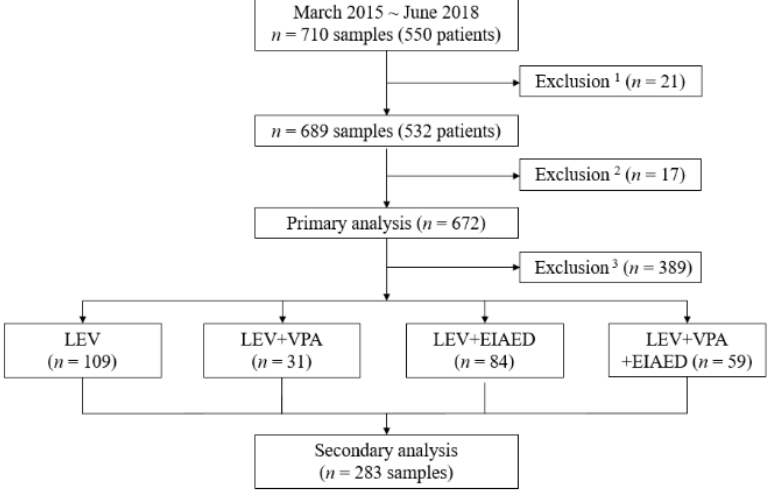
Figure 1. Study workflow. Abbreviations: LEV, levetiracetam; VPA, valproic acid; EIAED, enzyme- inducing antiepileptic drug. 1 Incomplete or unavailable medical record. 2 Below the lower limit of quantification. 3 Pediatric/elderly patient samples, intravenous injections, non-steady state samples, follow-up loss, low compliance, dose change, underlying liver and/or kidney diseases in addition to epilepsy. Table 1. Demographic and descriptive